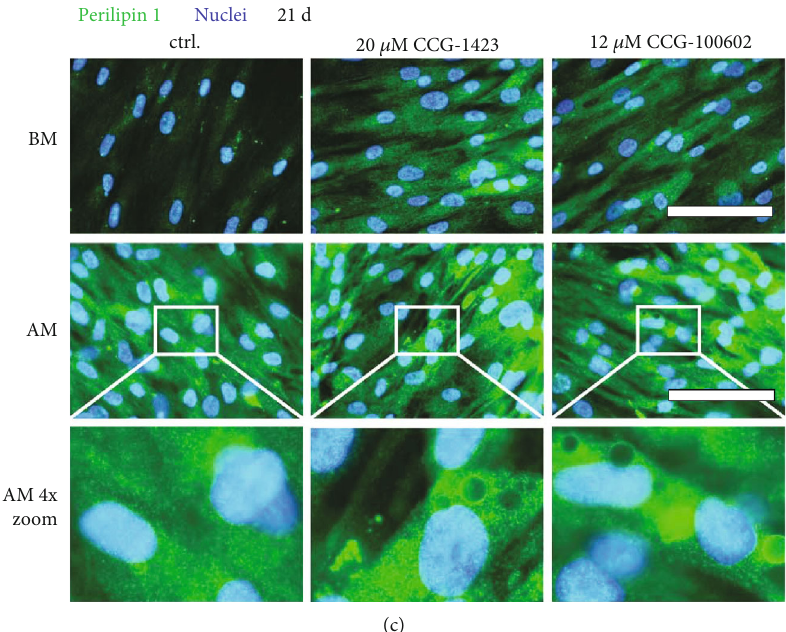
Figure 2: Adipogenesis of hASCs treated with MRTF-A inhibitors at 21d. hASCs were cultured 21 d in BM or AM conditions supplemented with 15 or 20 μ M CCG-1423 or 10 or 12 μ M CCG-100602 inhibitors and stained with ORO method. (a) Representative fl uorescence images of hASCs stained with ORO for intracellular lipid accumulation followed by nuclei staining with DAPI. Fluorescence images were taken with Alexa 546 for ORO (red) and DAPI (blue) fi lters, and 20x magni fi cation. Scale bars 100 μ m. (b) Lipid droplet areas were quanti fi ed from the ORO-stained fl uorescence images with a custom analysis pipeline designed for CellPro fi ler. The graphs present the total ORO-stained area or lipid droplet clusters with a diameter of over 5 μ m as percentages of the total image area. N = 36 for BM +20 μ M CCG-1423 and AM +20 μ M CCG-1423, other conditions N = 59 − 63 images (15 independent biological replicates from 4 donors). (c) Representative Plin1- and DAPI-stained samples of MTRF-A inhibitor-treated hASCs at 21d imaged with a fl uorescence microscope using Alexa 488 for Plin1 (green) and DAPI (blue) fi lters, and 40x magni fi cation. The lowest row represents 4x digital zoom of the white rectangles in AM images. Scale bars 100 μ m. BM: basic medium; AM: adipogenic medium; ORO: Oil Red